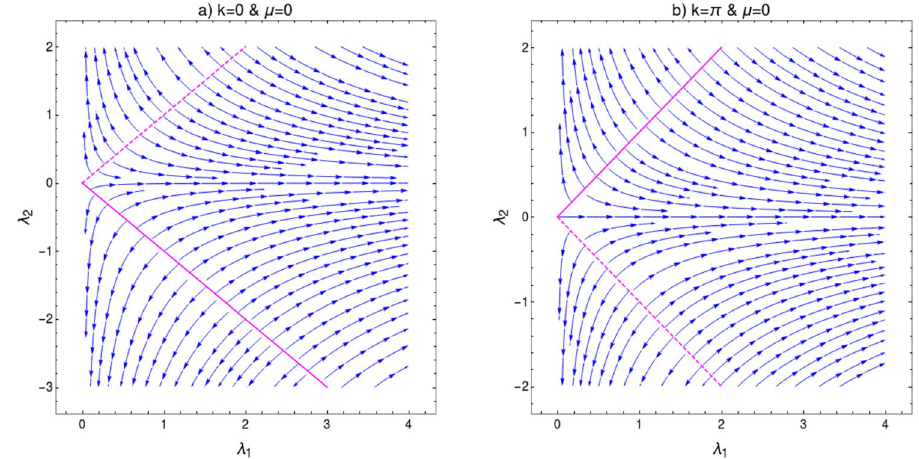
0 [Eqs. (17), (18)] at µ =